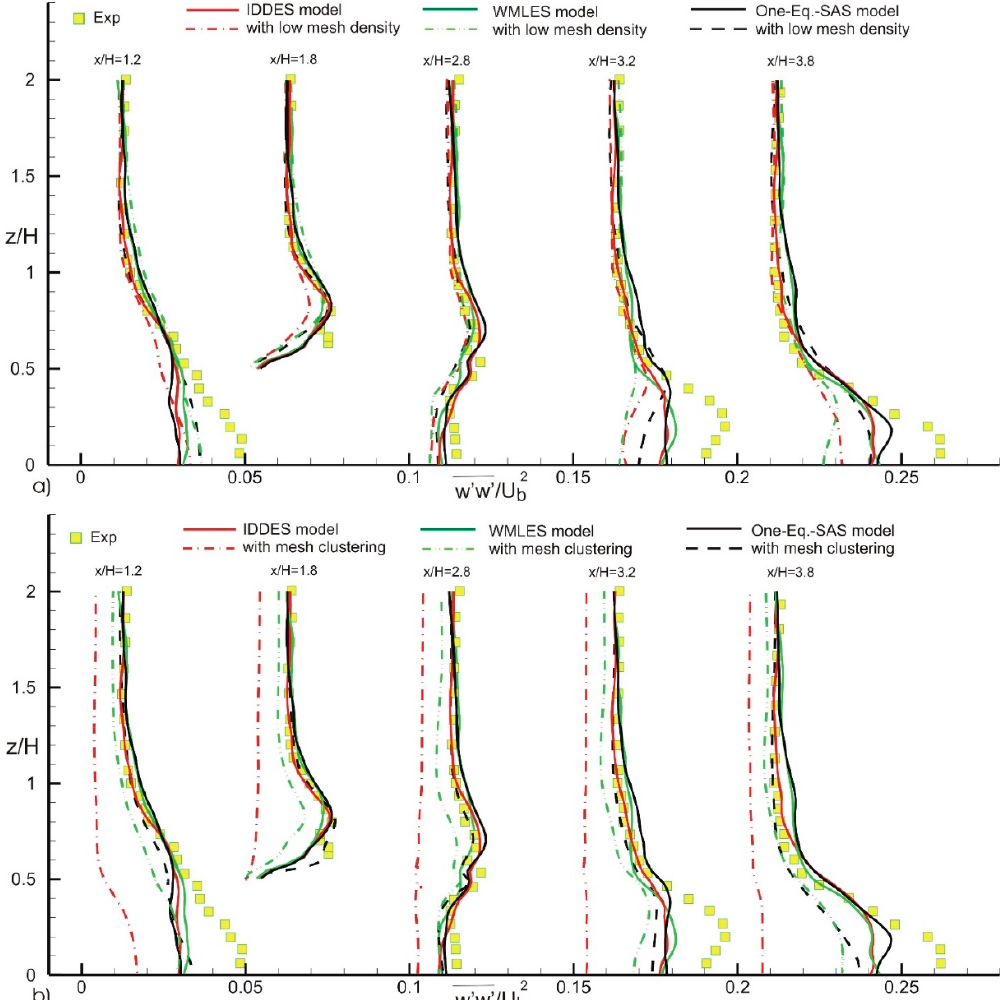
Figure 8. Effect of ( a ) mesh density, and ( b ) mesh clustering on the spanwise normalized Reynolds stress in the XY plane cutting through the center of the cube at z/H = 0.